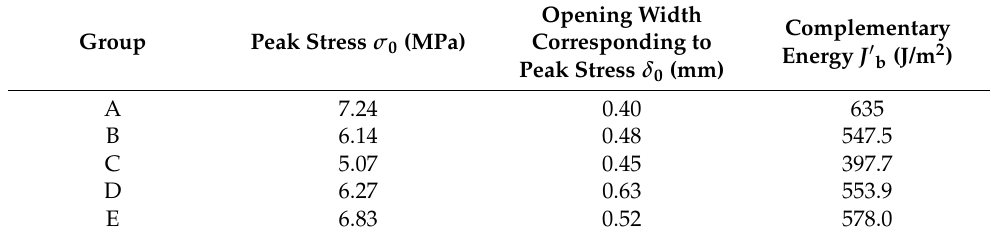
Table 5. Complementary energy of the ECC single-seam cracking test.